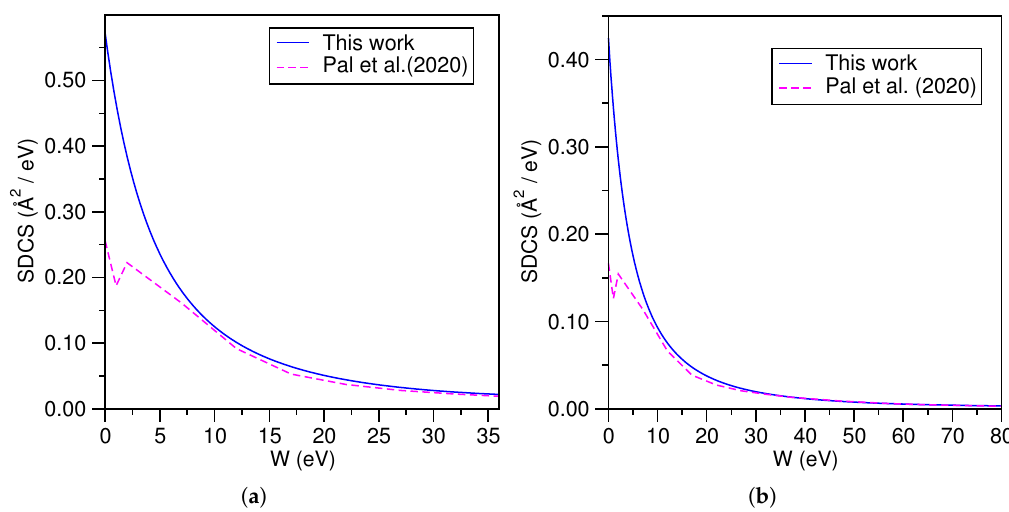
Figure 7. Electron-impact SDCS for C 2 H 2 at ( a ) T = 100 eV and ( b ) T = 200 eV. The solid lines represent the present work, and the dashed lines represent the theoretical data of Pal et al. [51], computed using the JK semiempirical approach.